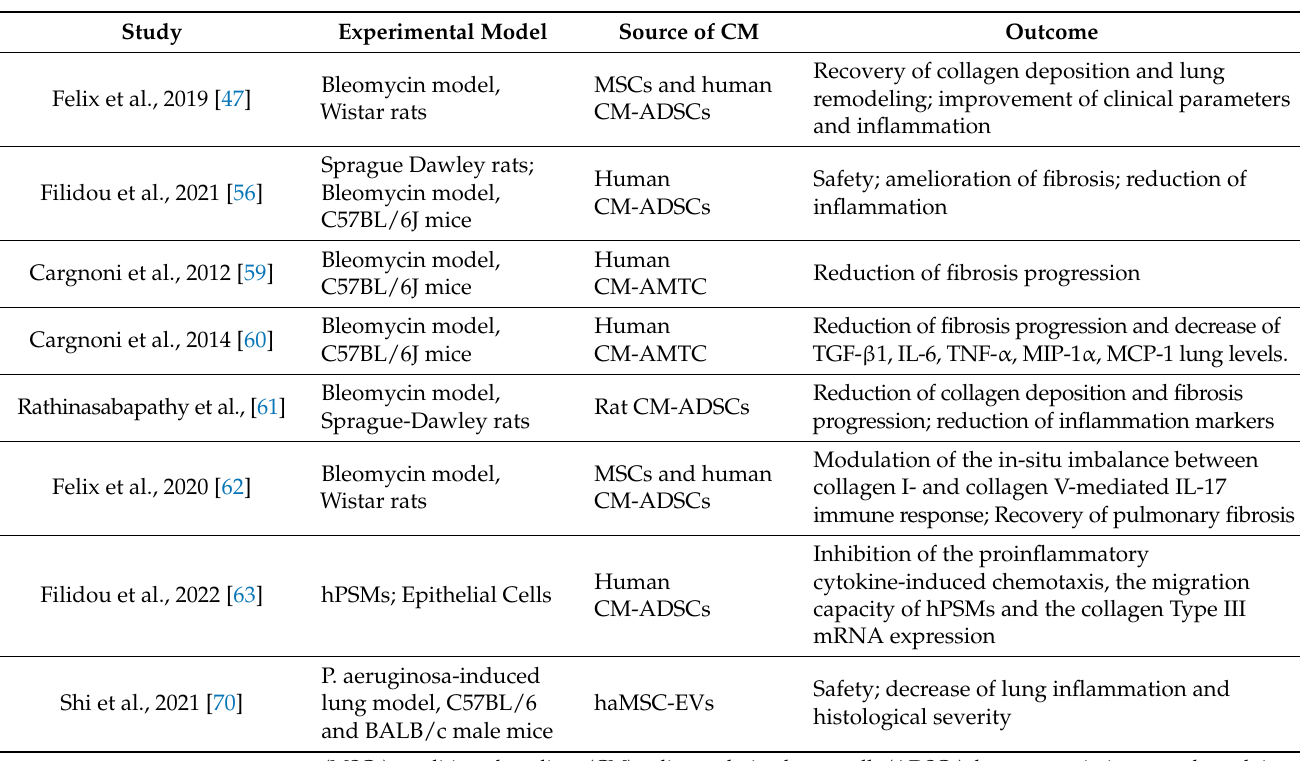
Table 1. Experimental studies on the effect of Mesenchyme Stem Cell-Derived Conditioned Medium in Idiopathic Pulmonary